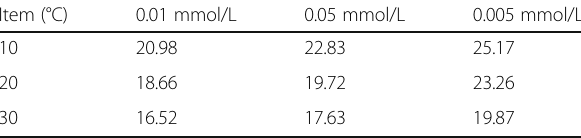
Table 4 Effects of temperature and ion strength on MCMs ’ adsorption capacity